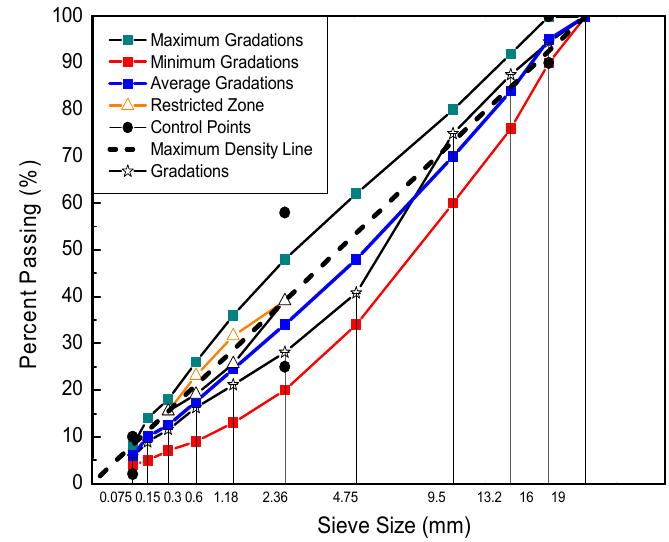
Table 1. Aggregate stockpile blend percentages.